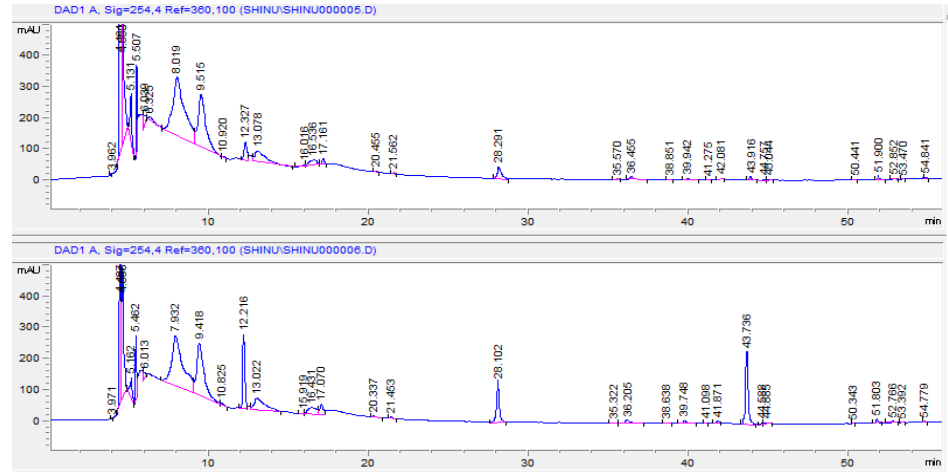
Figure 1. A comparison of the sample chromatogram of methanolic extract of Punica granatum leaves (upper panel) with the chromatogram of sample spiked with standard solutions of gallic acid, ellagic acid, and apigenin (lower panel).